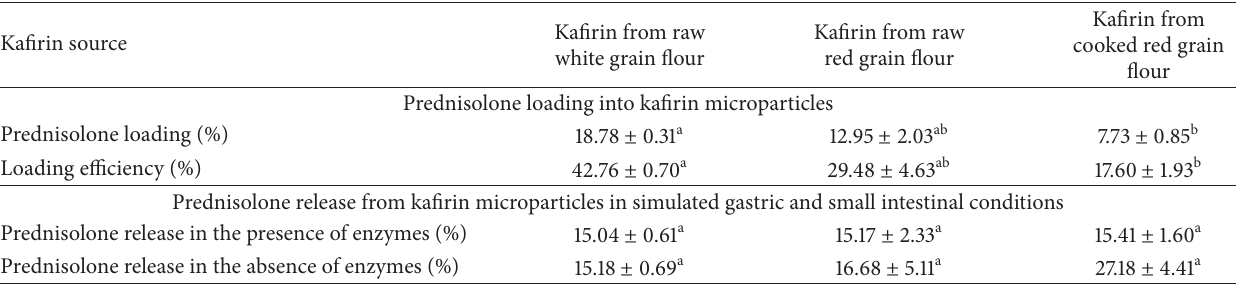
Table 2: Drug loading, loading efficiency, and prednisolone release (mean ± SEM, 𝑛 = 3 ) of prednisolone-loaded kafirin